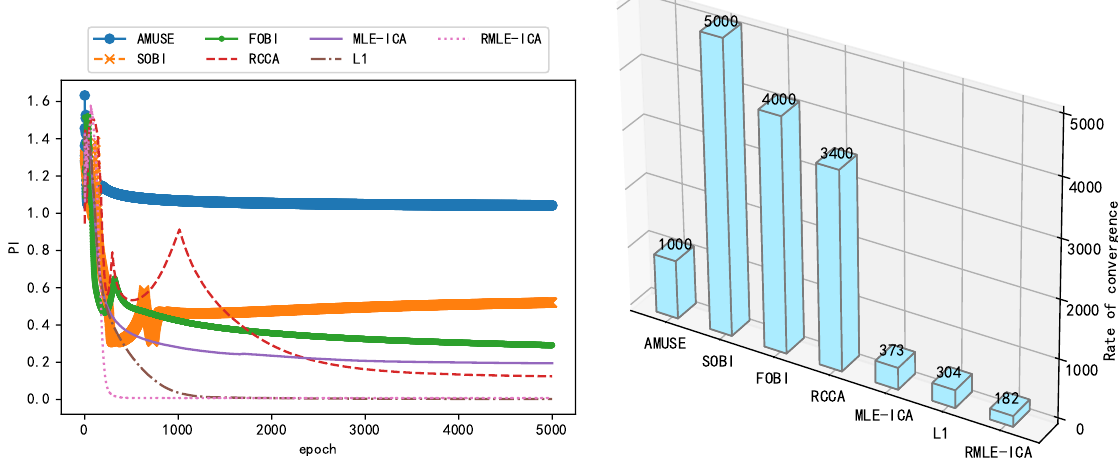
( b ) Comparison of convergence speed of different algorithms Figure 7. Comparison of computational performance between the proposed algorithm and competing